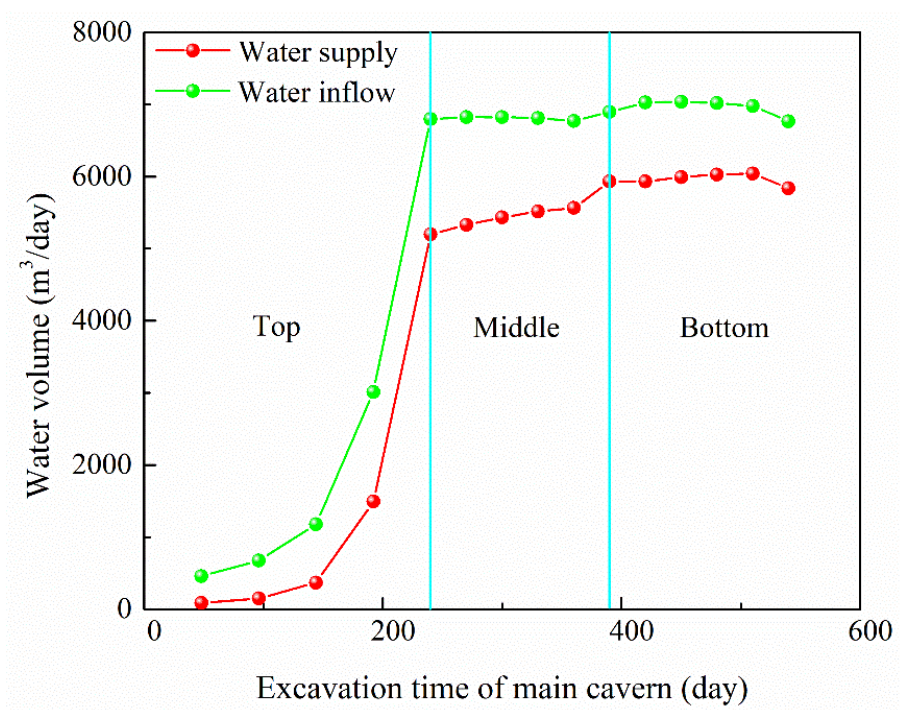
Figure 12. Section positions on plane view.